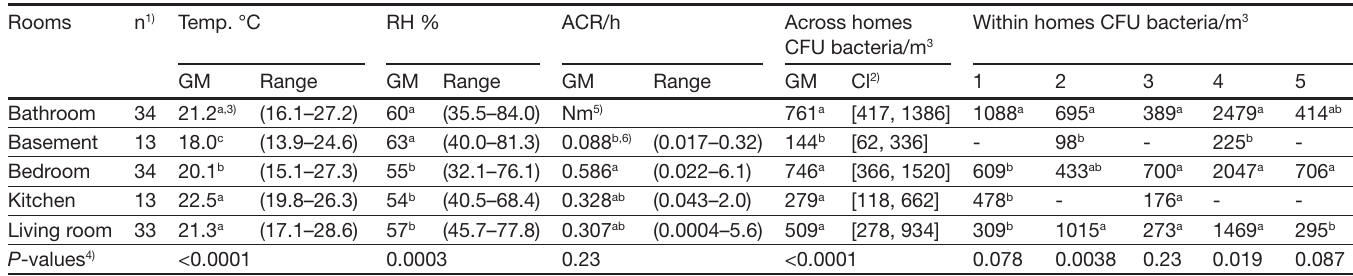
Table 1. Temperature, RH and ACR, and concentrations of bacteria (GM, CFU/m 3 ) in different rooms in homes 1–5